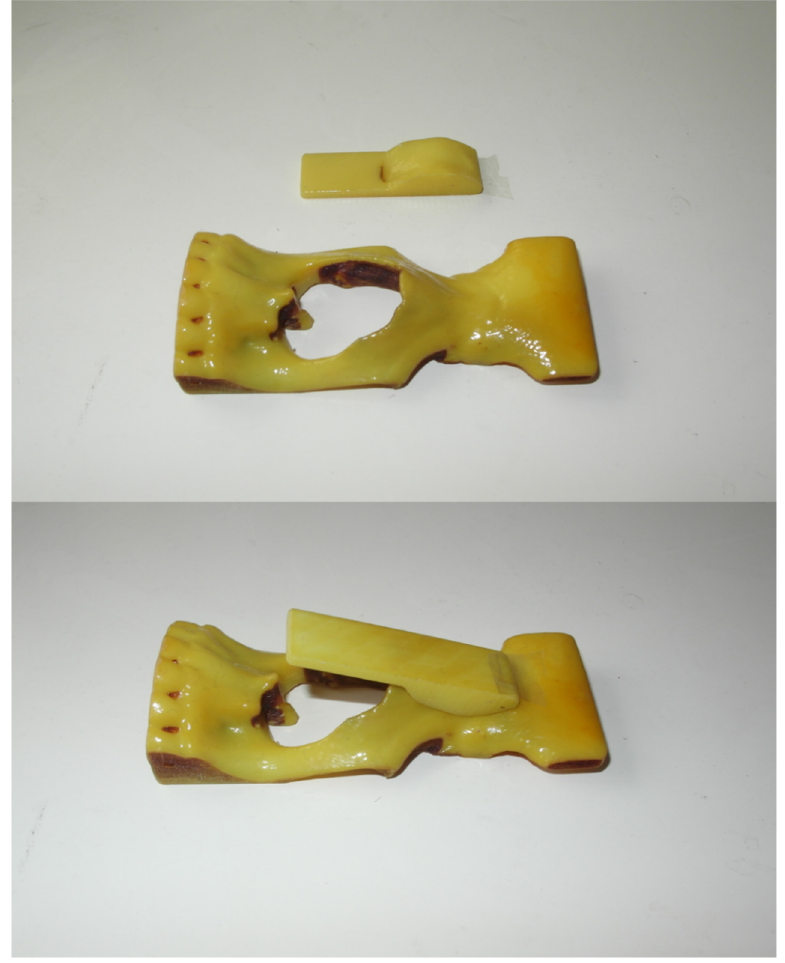
Figure 1. An example of the 3D printing model of PLA material. We can use the model to help to simulate the surgical scene.